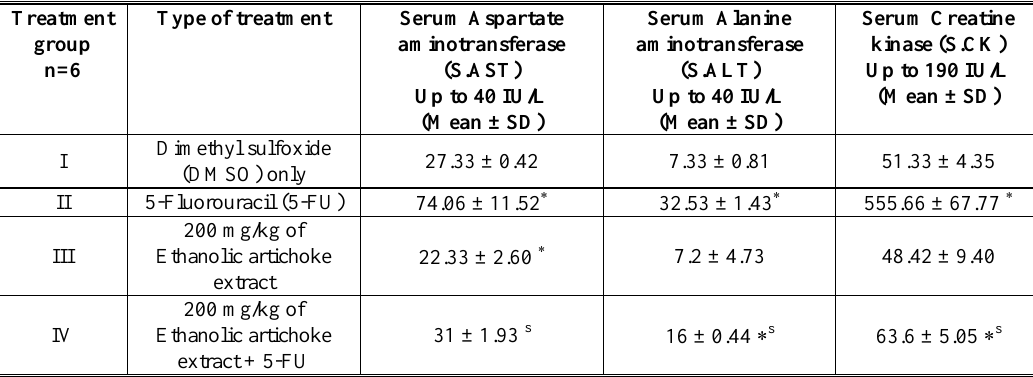
Table (1): Effects of ethanolic artichoke extract (200 mg/kg) on the serum levels of AST, ALT and CK in albino female rats with 5-FU induced cardiac toxicity, data are expressed as Mean ± SD, n =6,  p <0.05. Standard deviation (SD), 5-Fluorouracil (5-FU) and dimethyl sulfoxide